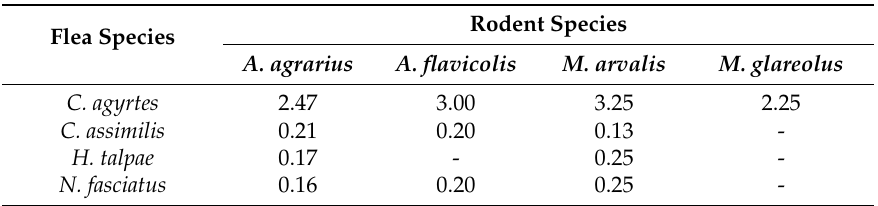
Table 4. Host preferences of the studied flea populations in eastern Poland ( < 1–low index of host preferences, > 1–high index of host preferences).